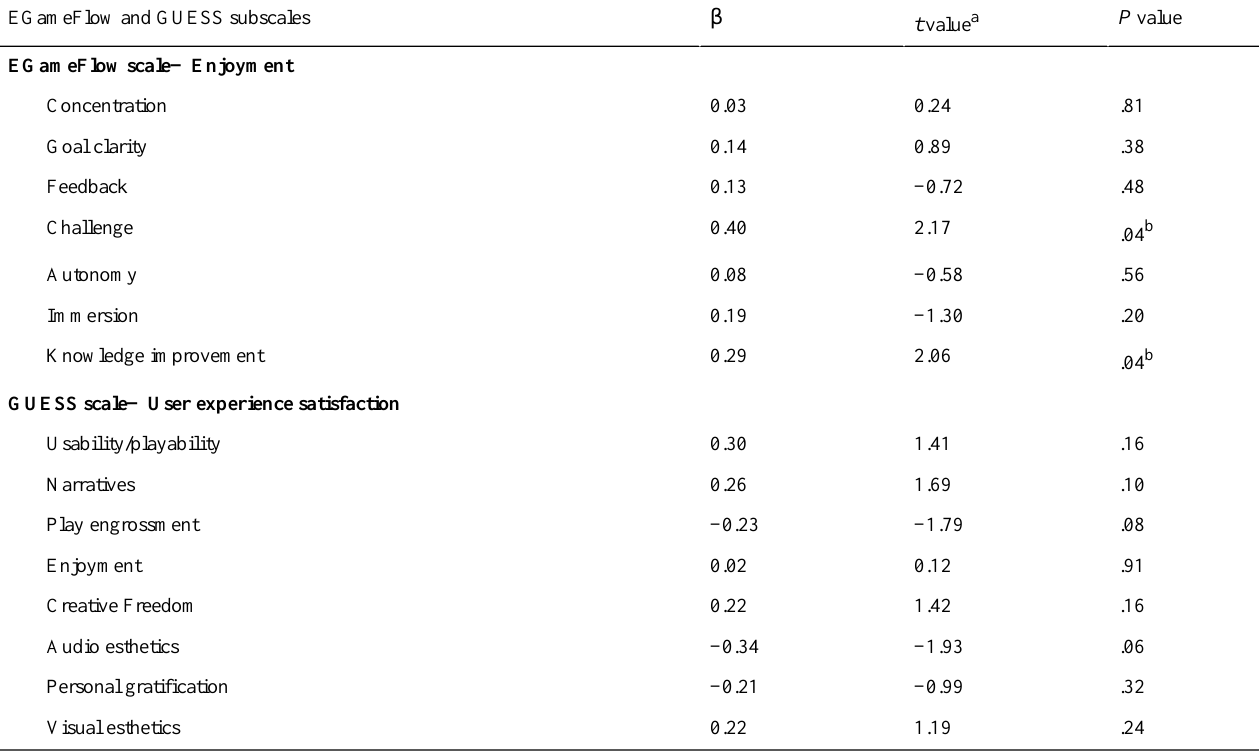
Table 2. Model coefficients for EGameFlow and GUESS subscale ratings with posttest knowledge as the dependent variable.